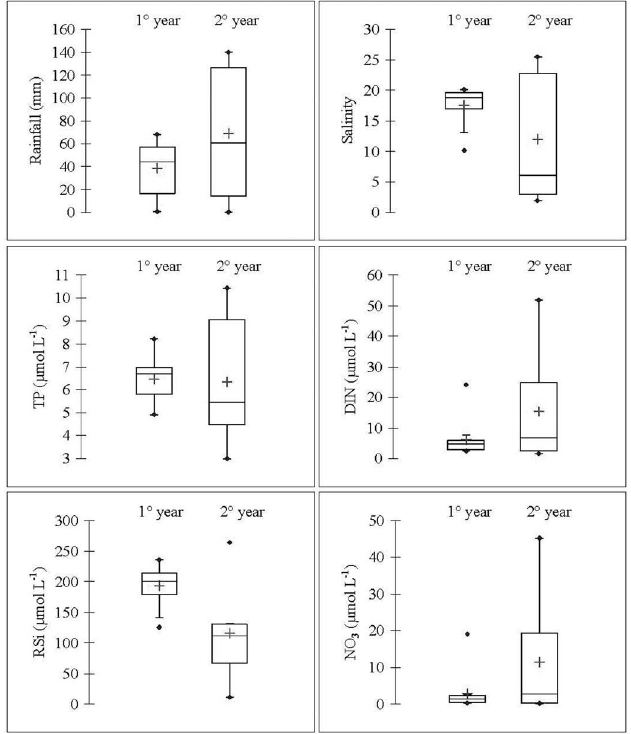
Fig . 3. – Statistical distribution of mean values of the environmental parameters and nutrients that have varied mostly in Cabras Lagoon during the two annual cycles. The whiskers indicate the range containing 1.5 times the interquartile range, and the dots outside the whiskers are outliers .